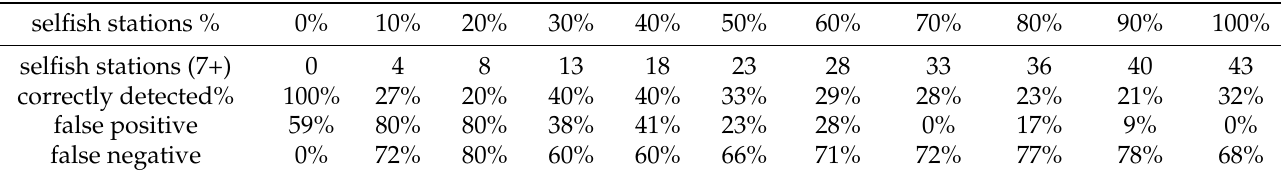
Table 10. ISSD detection for 50 stations with 2 slots in TCP IP camera